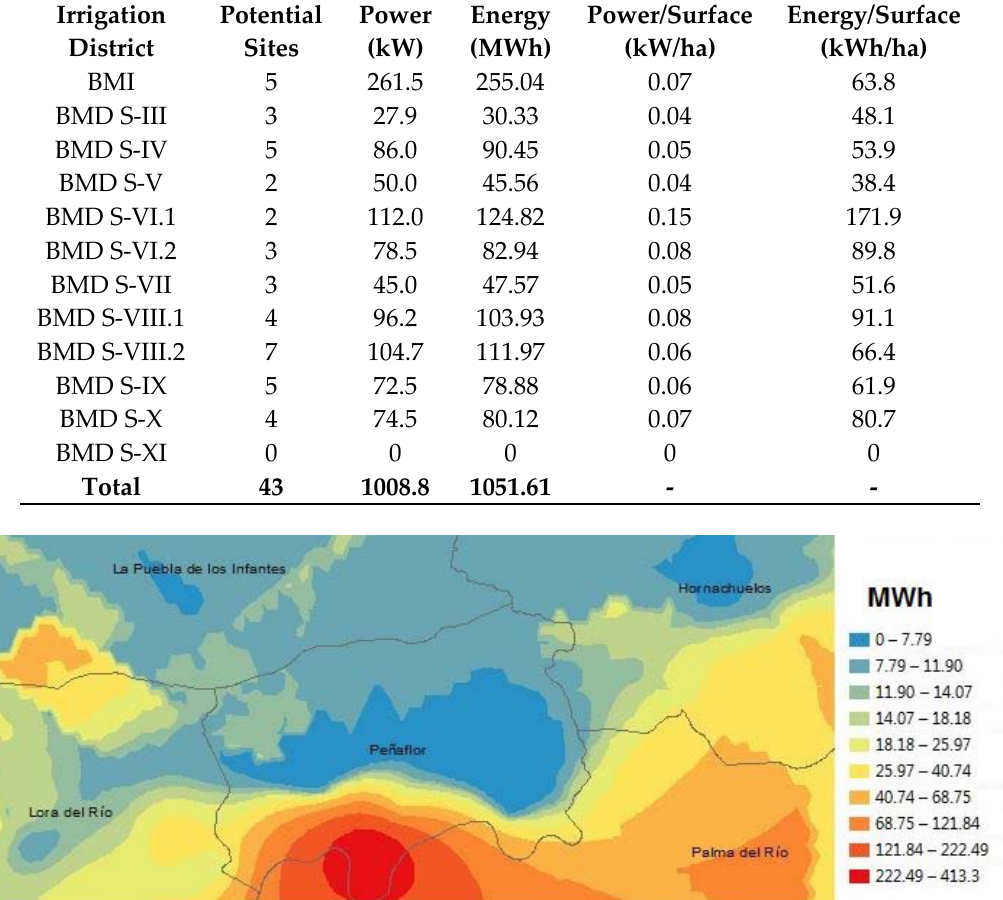
Figure 2. Gradient map of the potential energy that could be recovered, in kWh, using MHP turbines and/or PATs in the 12 irrigation networks studied, generated using Kriging interpolation